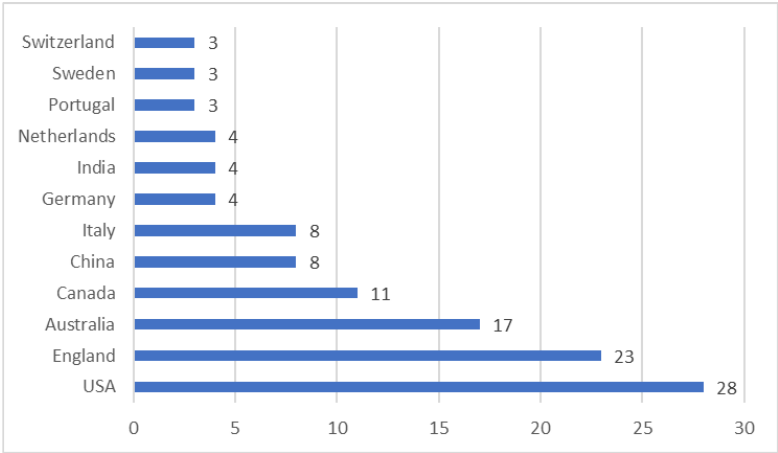
Figure 7. Number of articles per country.